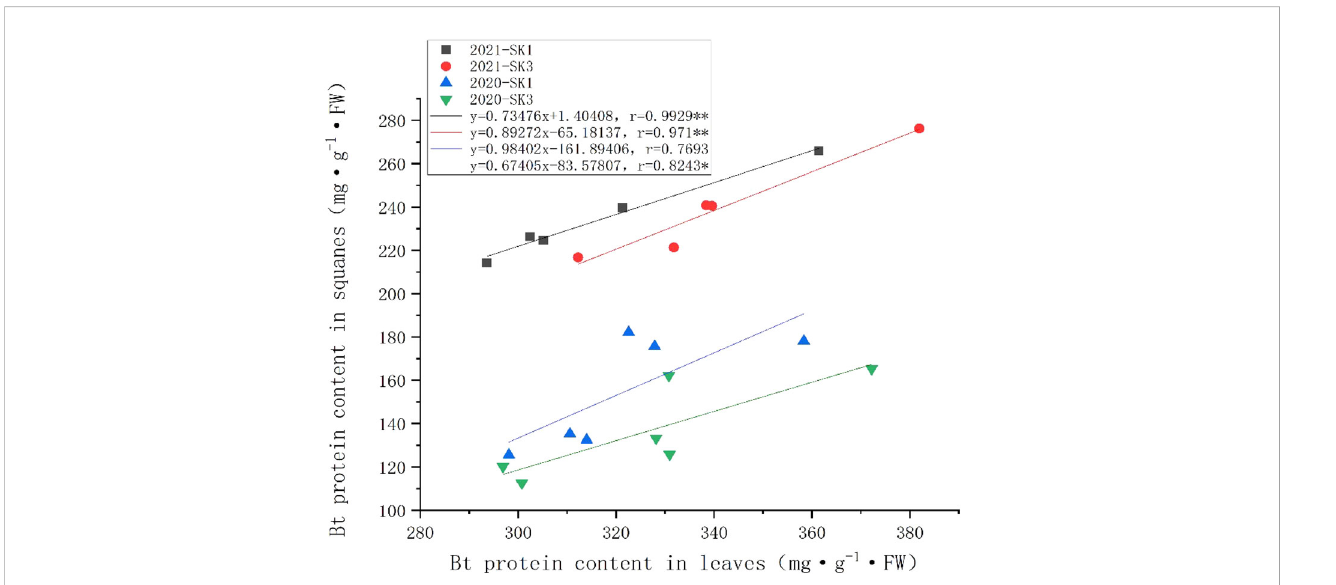
FIGURE 3 Correlations between Bt insecticidal protein content in leaves and squares after 48 h low temperature stress in 2020 and 2021. Asterisks indicate signi fi cance at 0.05 (*) and 0.01 (**)